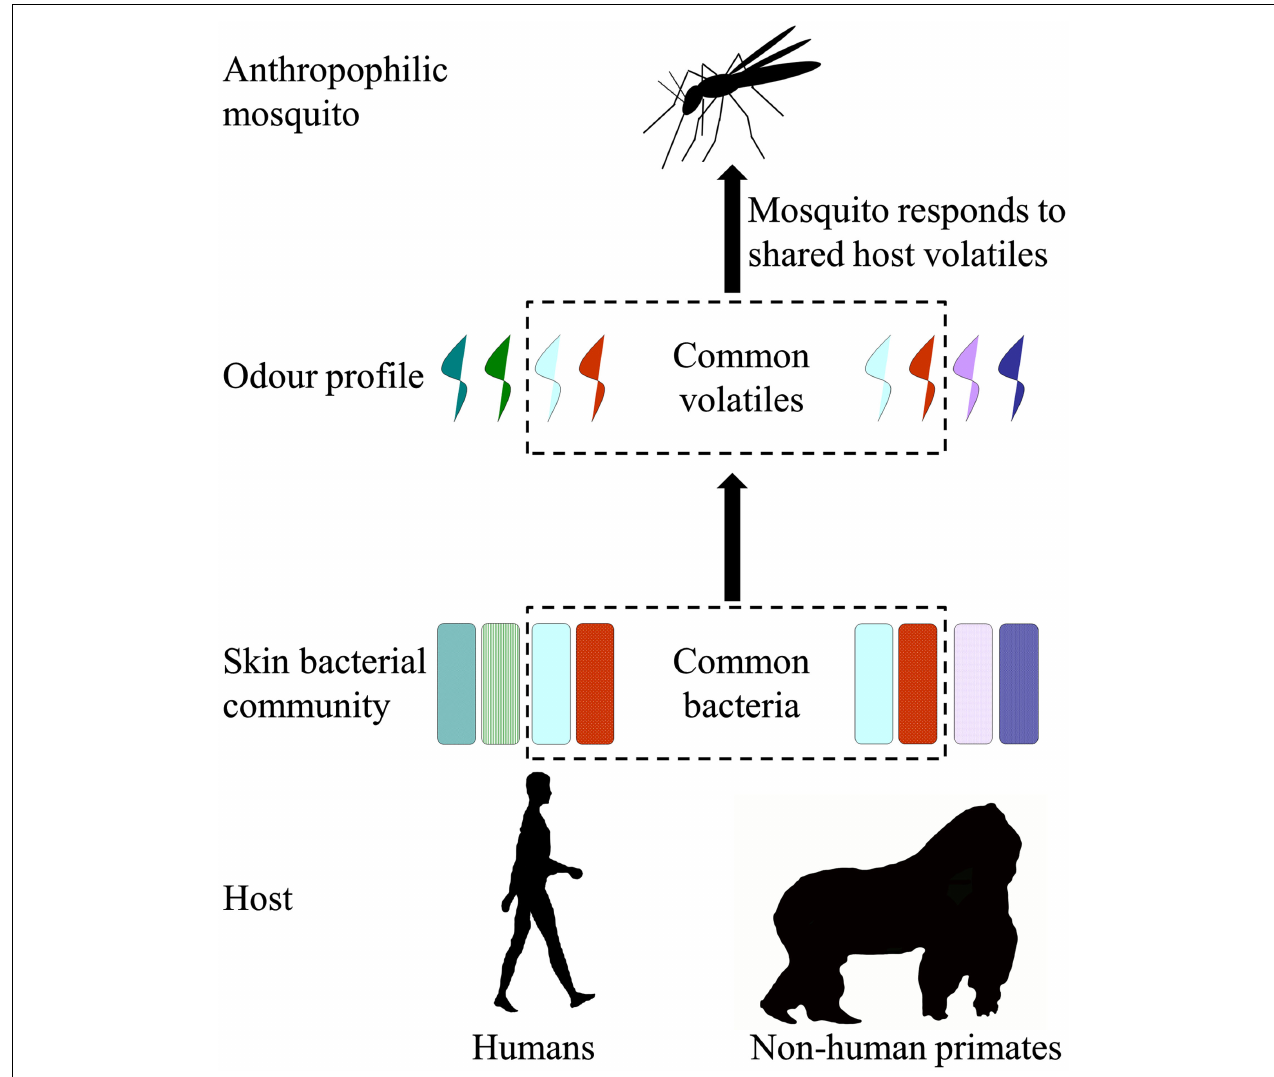
FIGURE 2 | Mosquito-host interactions and the possible response of anthropophilic mosquitoes to volatiles shared by humans and non-human primates.